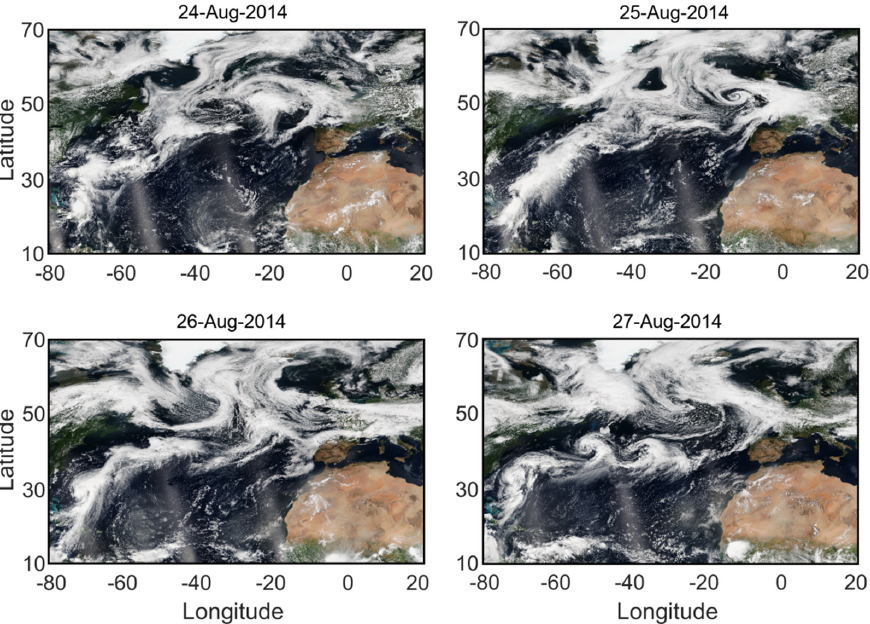
Figure 8. GOES mosaic in visible channels covering the different stages of the AR from 24 ( top left ) to 27 August 2014 ( bottom right ).